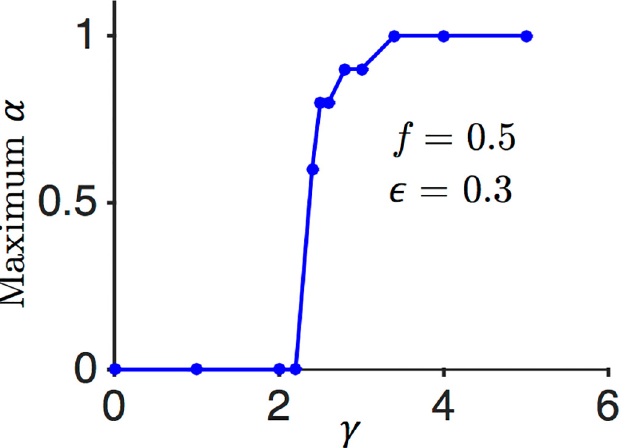
Fig 5. Dependence of the critical capacity on the strength of the external input. We varied the strength of the external field ( γ ) in order to quantify its effect on the learning process. The critical capacity is plotted as a function of γ at a fixed robustness (cid:2) = 0.3 in the dense regime f = 0.5. The simulations show that there is a very sharp drop in the maximum α when γ goes below (cid:5) 2.4.